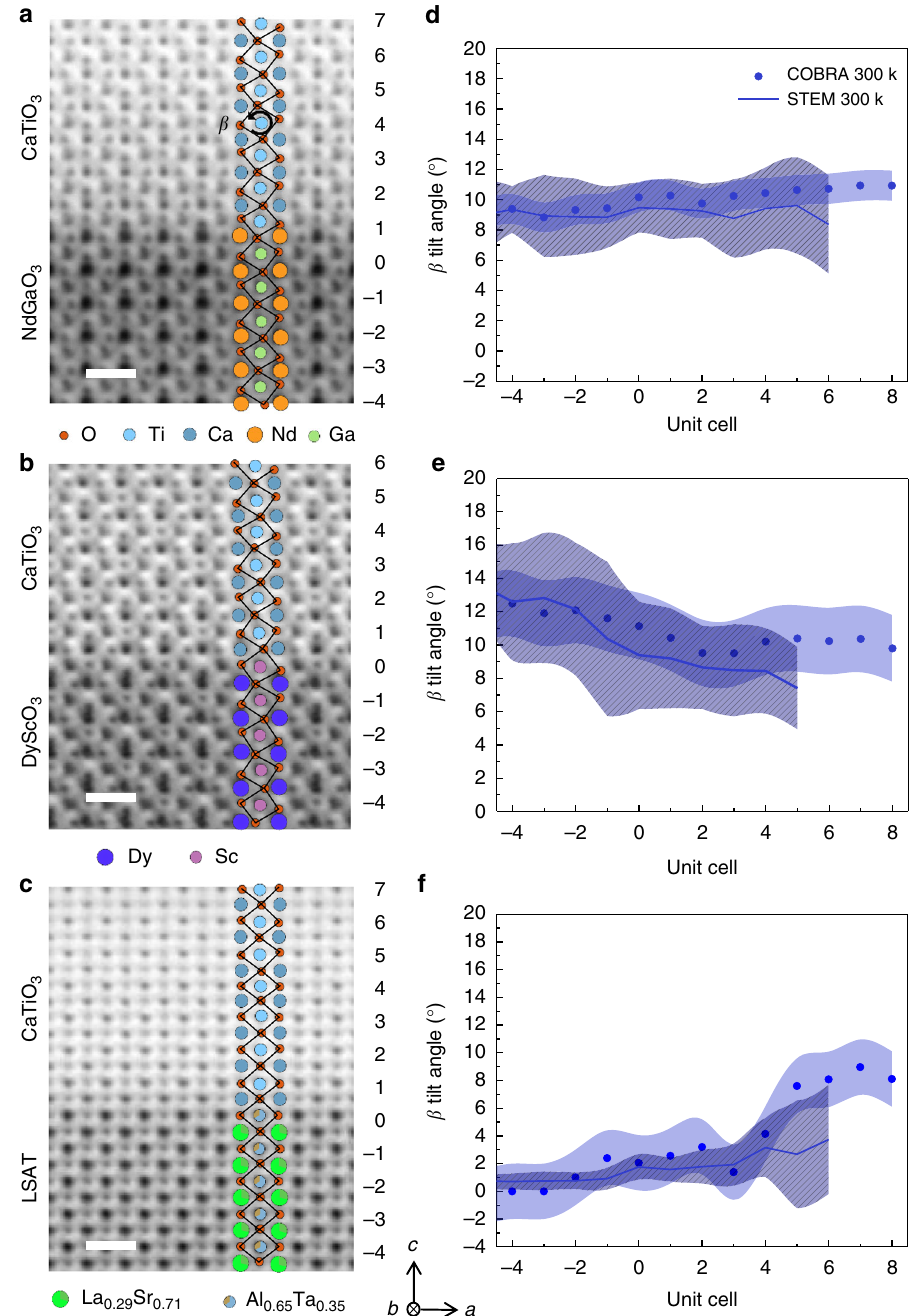
Fig. 4 Room temperature evolution of β angles across interfaces. High resolution annular bright fi eld scanning transmission electron microscopy (ABF- STEM) images with oxygen atoms at room temperature for a CaTiO 3 /NdGaO 3 , b CaTiO 3 /DyScO 3 , c CaTiO 3 /LSAT along [010] pc ( b -axis) zone axis. Different unit cells are labeled by numbers on the right side of the STEM images. The scale bar is 5 Å. The β angles (blue lines) resolved by STEM for different unit cells along c direction are plotted in d , e , and f , respectively for above systems. As comparison, room temperature coherent Bragg rods analysis (COBRA) data are plotted using blue dots. Experimental errors for STEM (line shaded area) are taken to be the standard deviation of the β values along a -axis over around 20 unit cells. The errors for COBRA data (light blue shaded area) are obtained by comparing substrates β values to their